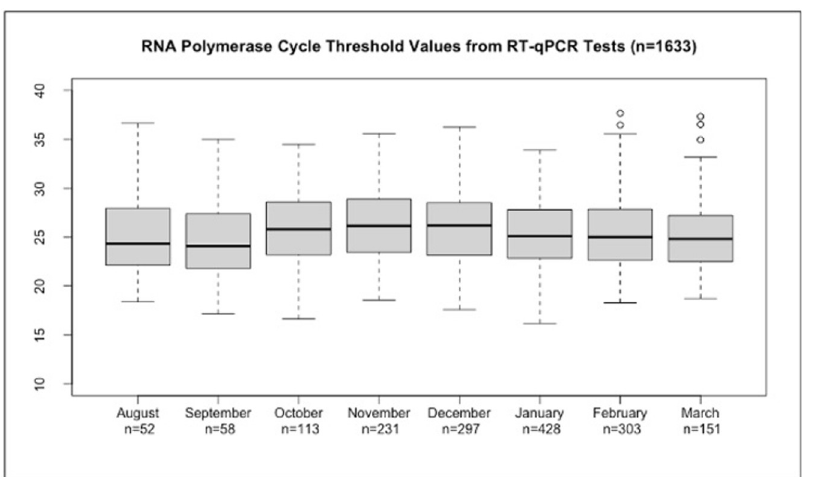
Fig 1. RNA polymerase cycle threshold values by month over the course of the study.